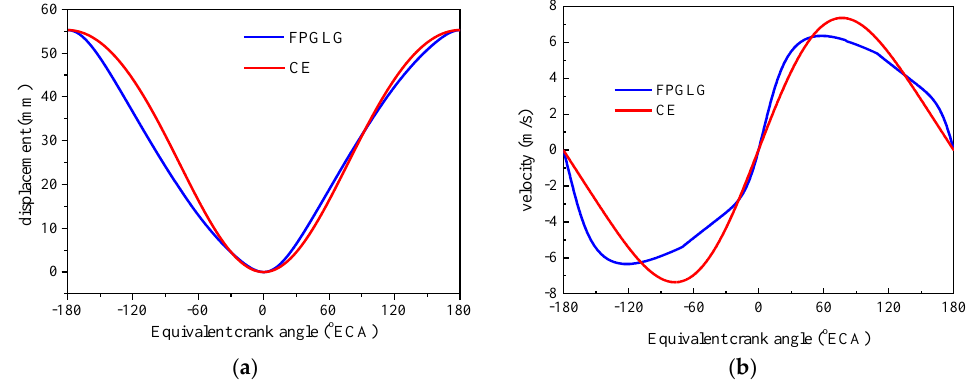
Figure 5. ( a ) The piston displacement curves of the FPGLG and the CE; ( b ) The piston velocity curves of the FPGLG and the CE.